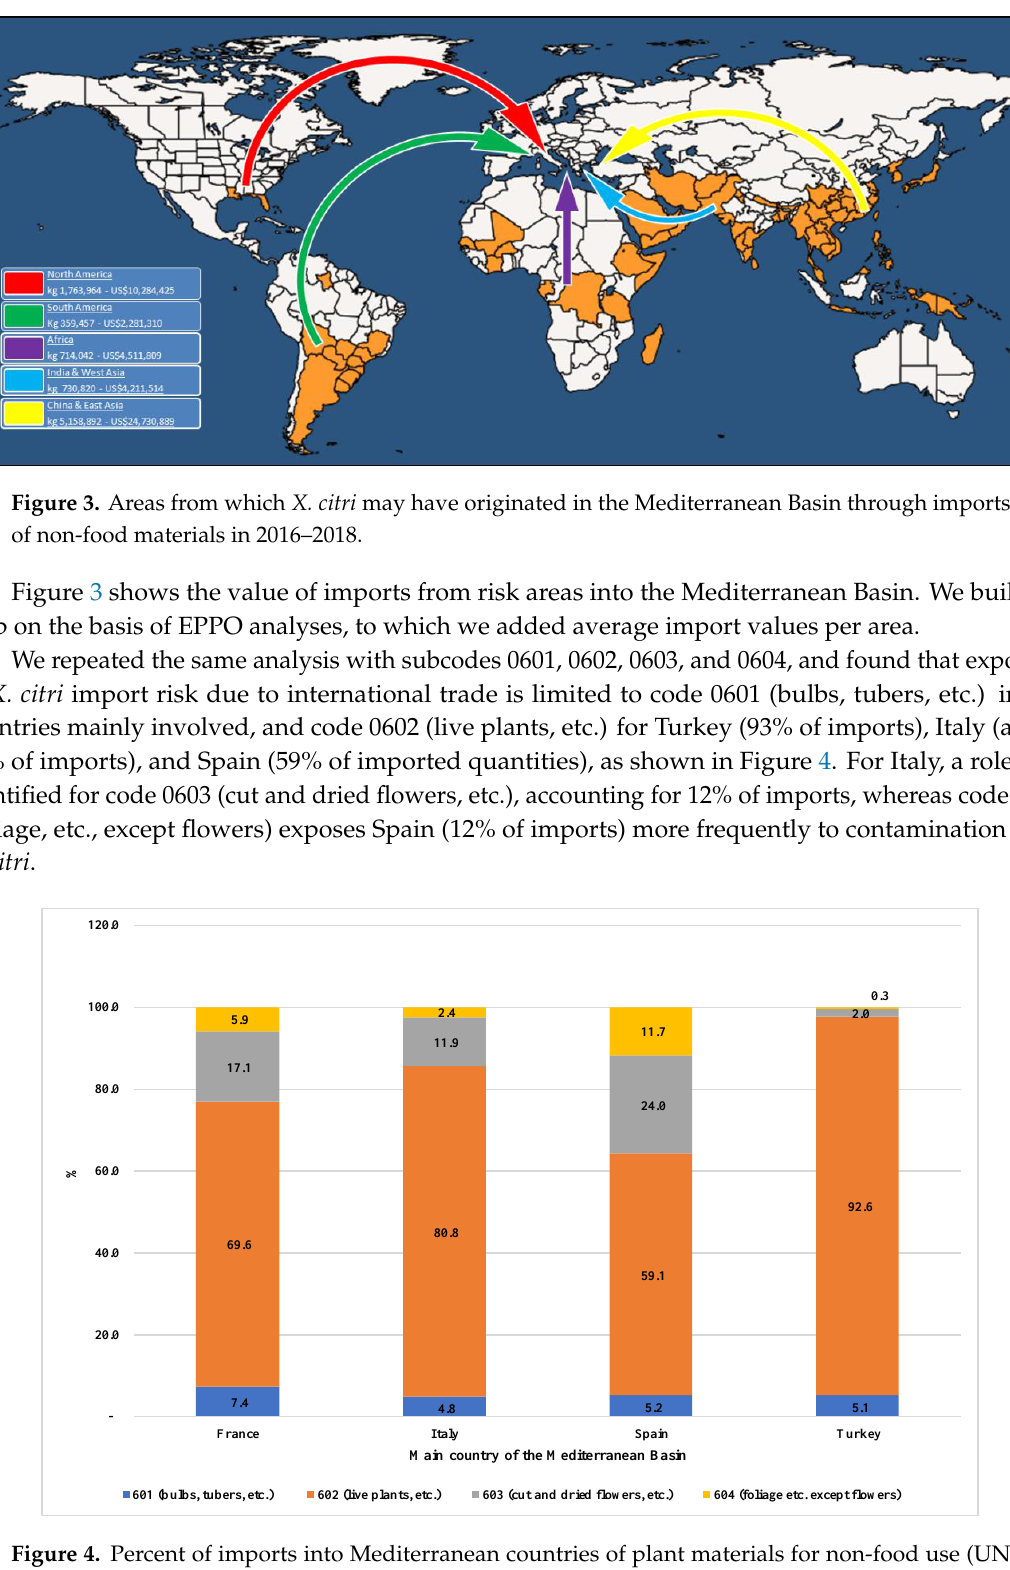
Figure 4. Percent of imports into Mediterranean countries of plant materials for non-food use (UN Comtrade code 06) by subcode in 2018.